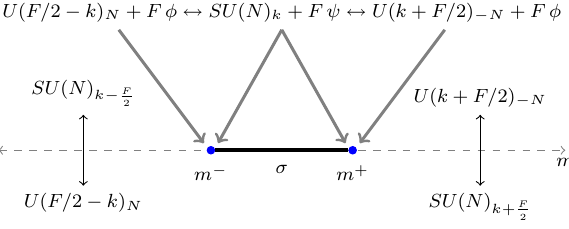
Fig. 2 Phase diagram of SU ( N ) k + F ψ with k < F /